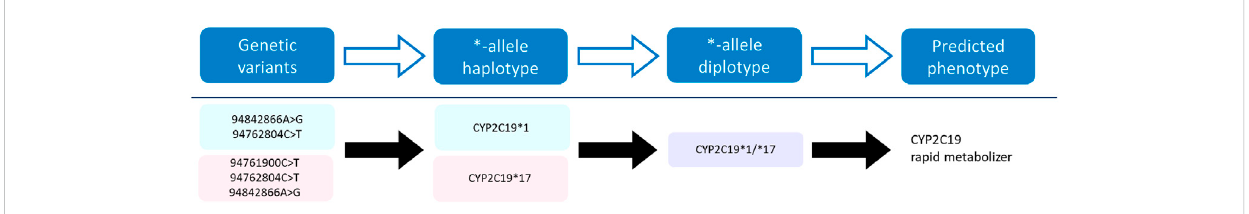
FIGURE 1 Visualization of the process towards predicting a phenotype. Genetic variants of the CYP2C19 gene on the maternal ( pink ) and paternal ( blue ) allele are assigned a haplotype, which combined form a diplotype ( purple ). This diplotype is translated into a predicted phenotype on which the treatment will be based.